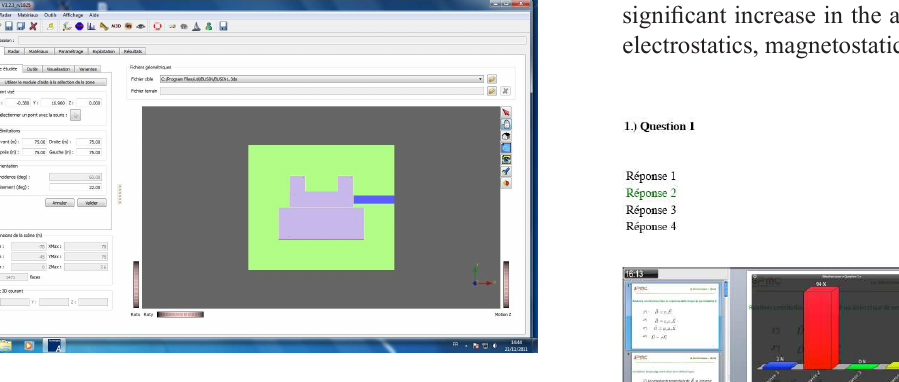
Figure 3: One of the proposed configuration in MO- CEMLT: industrial building